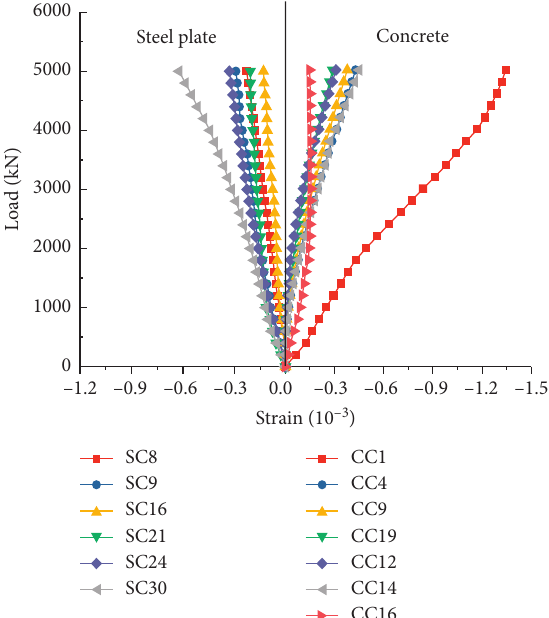
Figure 27: Load-strain relationship of SC-N1 in compressive experiment.